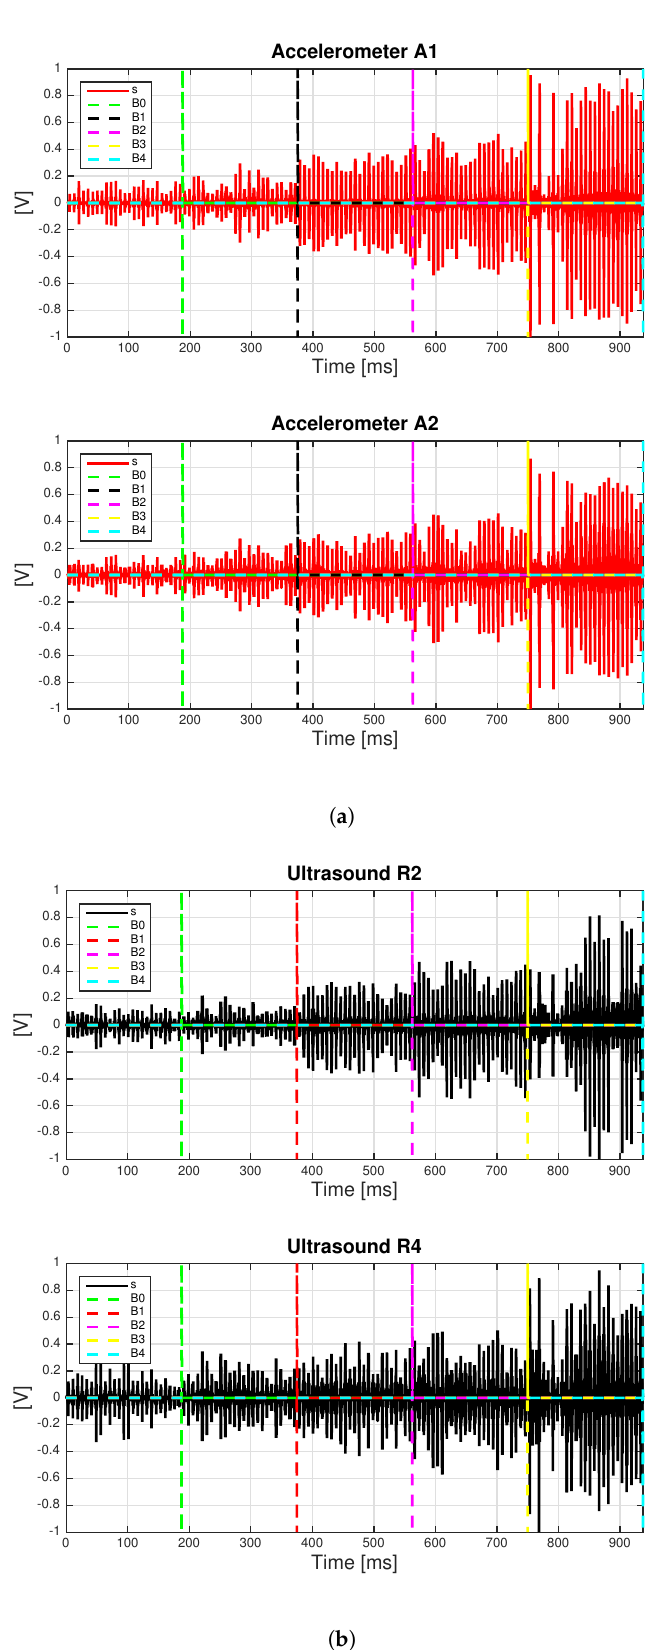
Figure 9. Sensors recordings in passive configuration, 1 buffer triggered by A1: ( a ) accelerometers and ( b ) ultrasound